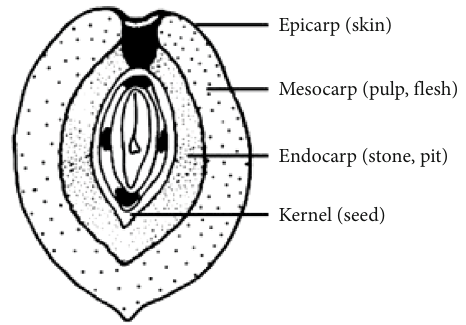
Figure 1: Olive fruit